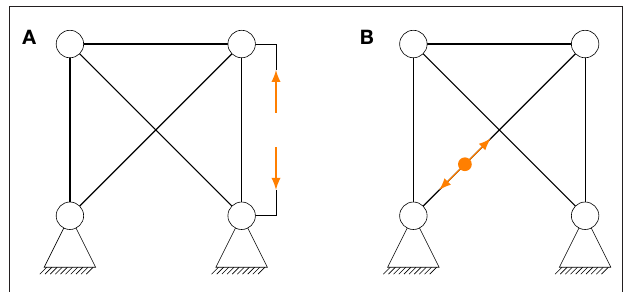
FIGURE 1 | Two actuation principles for adaptive structures (A) parallel force and (B) serial